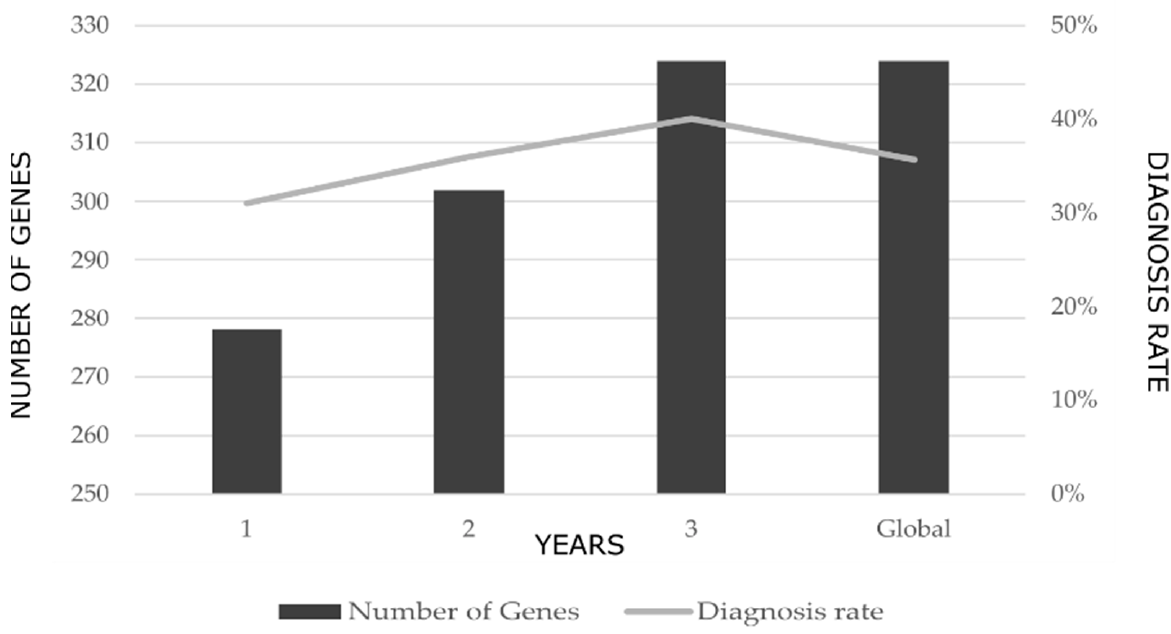
Figure 1. Change in the rate of diagnosis with the successive addition of genes to the multi-gene panel over the 3-year study period. The global value represents the mean rate of diagnosis over the entire study period.